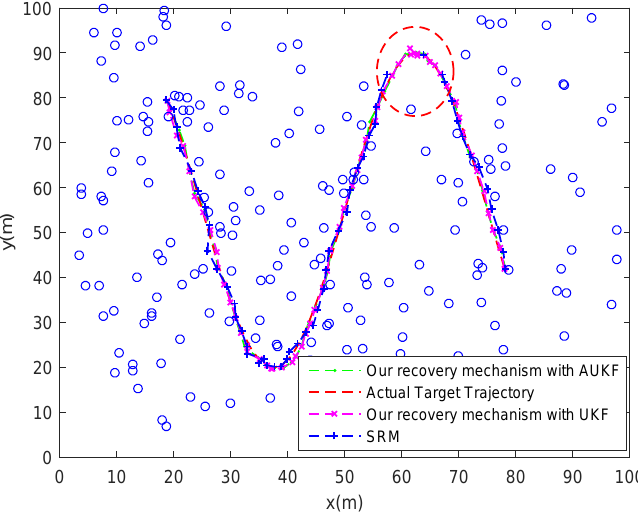
Figure 14. Tracking trajectories of the target under different recovery mechanism when the target enters a coverage